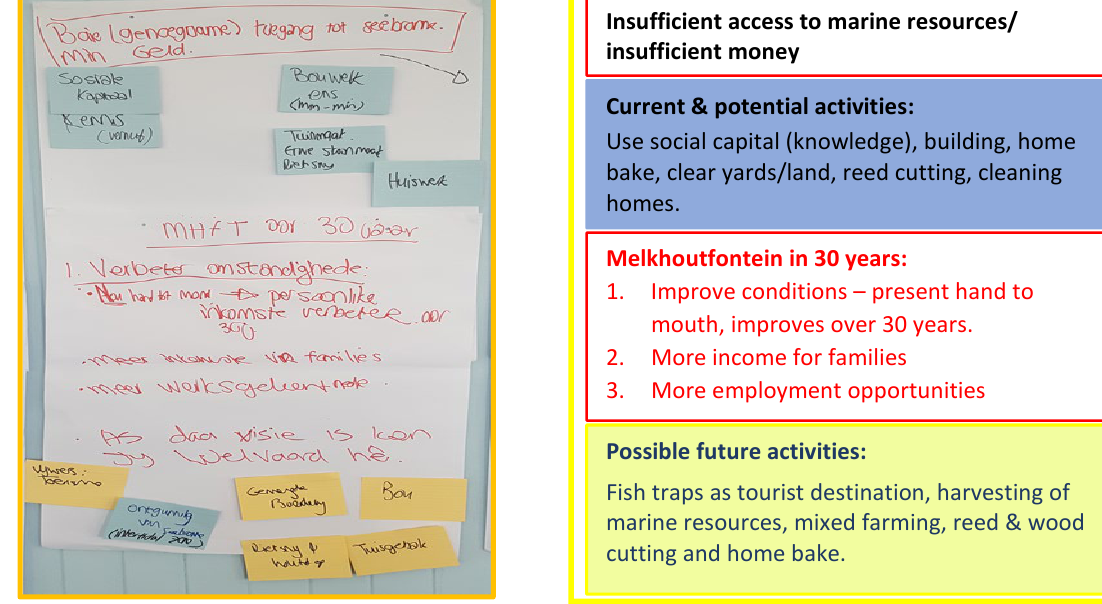
Figure A1.2. Elements of the “Sufficient access to Marine resources/low disposable income scenario” as identified in workshop 3: blue cards depict current and potential activities that participants engage in the present time. The red text reflects the town in 30 years, and yellow cards indicate future livelihood activities that could be engaged in. The left panel shows a photograph of the results of the original story exercise in Afrikaans, whilst the right panel provides a